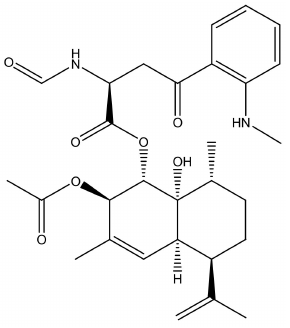
Figure 1. Structure of